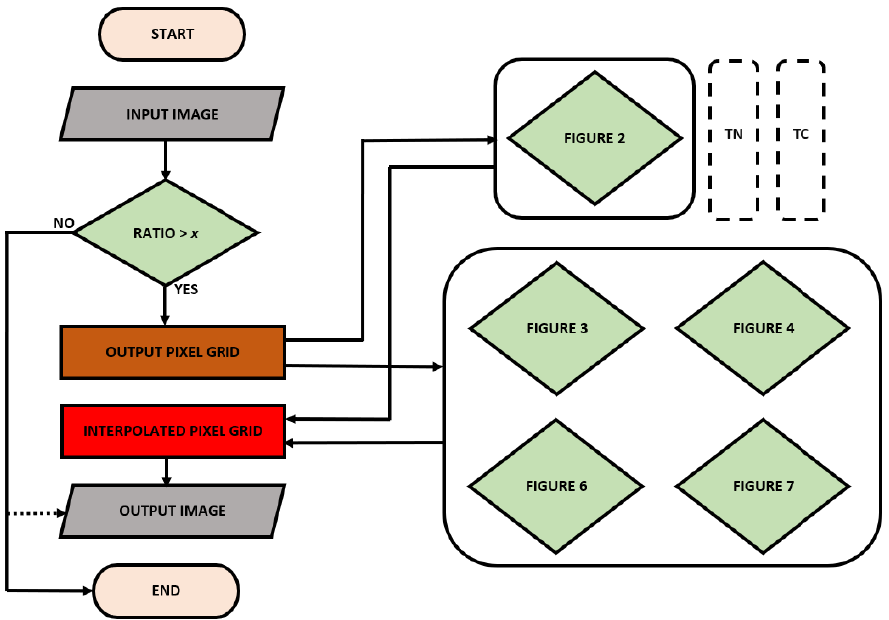
Figure 8. A simplified flowchart showing the image interpolation procedure followed by TB (Figure 2), MD (Figure 3), HR (Figure 4), AT (Figure 6), and AC (Figure 7) methods. 206